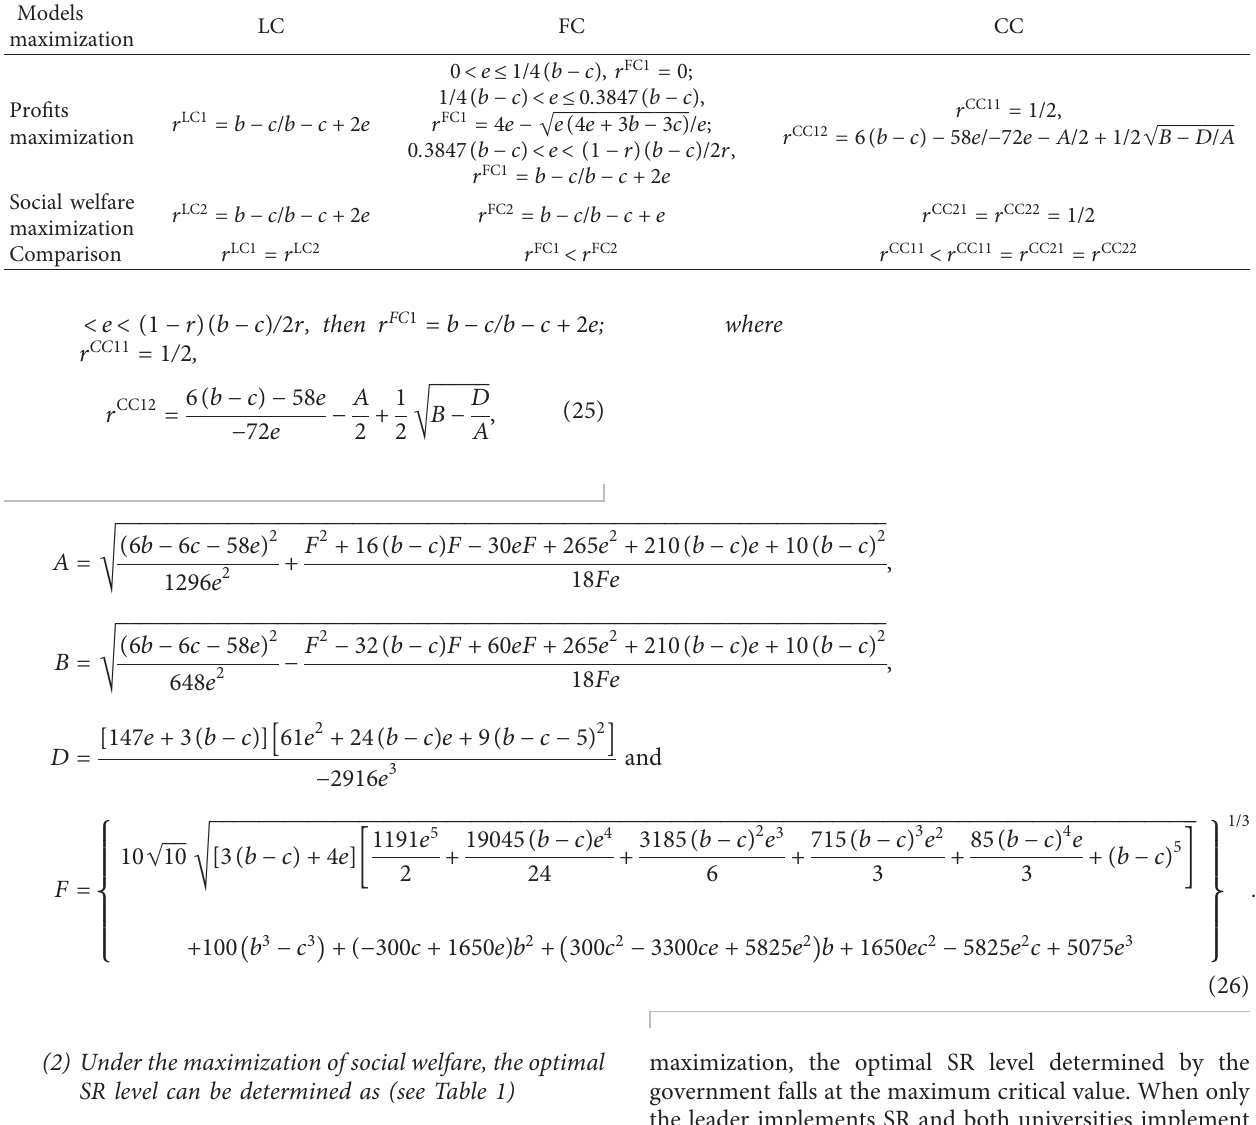
Table 1: The optimal SR